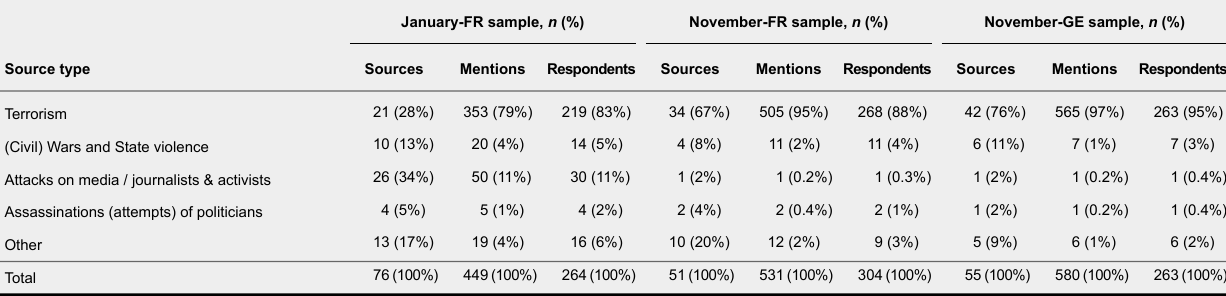
Types of Specific Analogical Sources and Their Frequencies Across